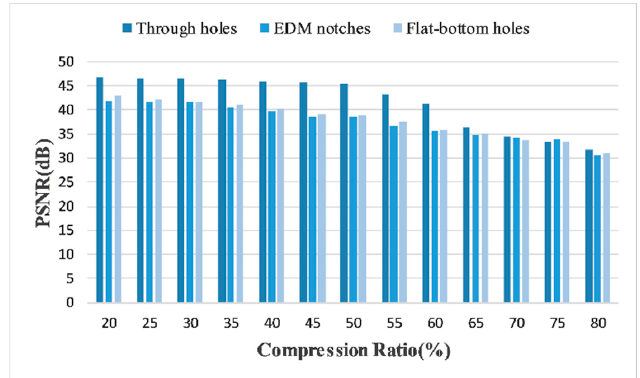
Figure 16. Comparative PSNRs between three kinds of defects in time domain, using 50 MHz SR experimental data.